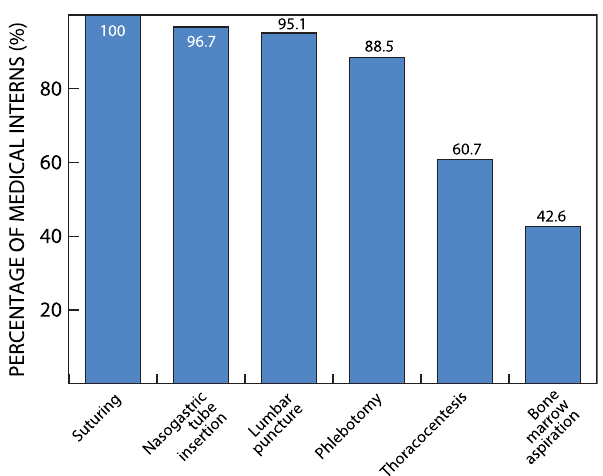
Figure 2: Percentage of medical interns who have performed listed medical procedures at undergraduate